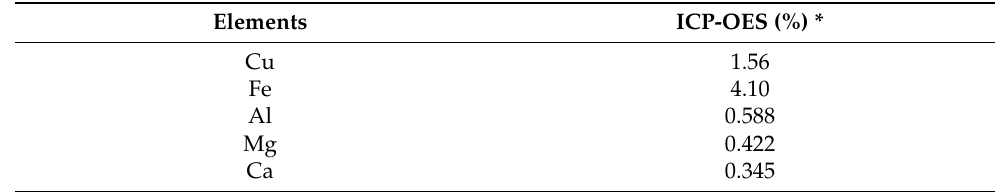
Table 1. Composition of element eluted through aqua regia extraction in the ore sample collected from Almalyk mine in